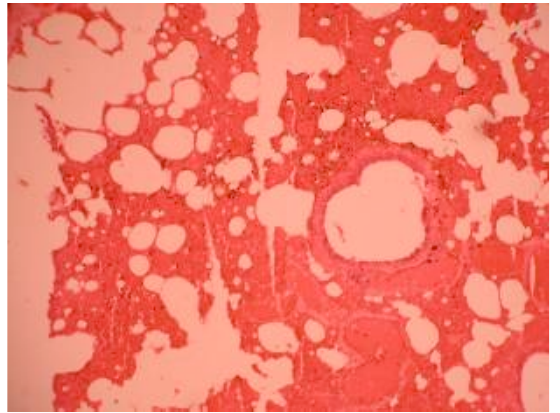
Image 16. Lung of Beisa oryx showing deposition of carbon particles, granuloma and collapsed alveoli, Anthracosis, H&E,